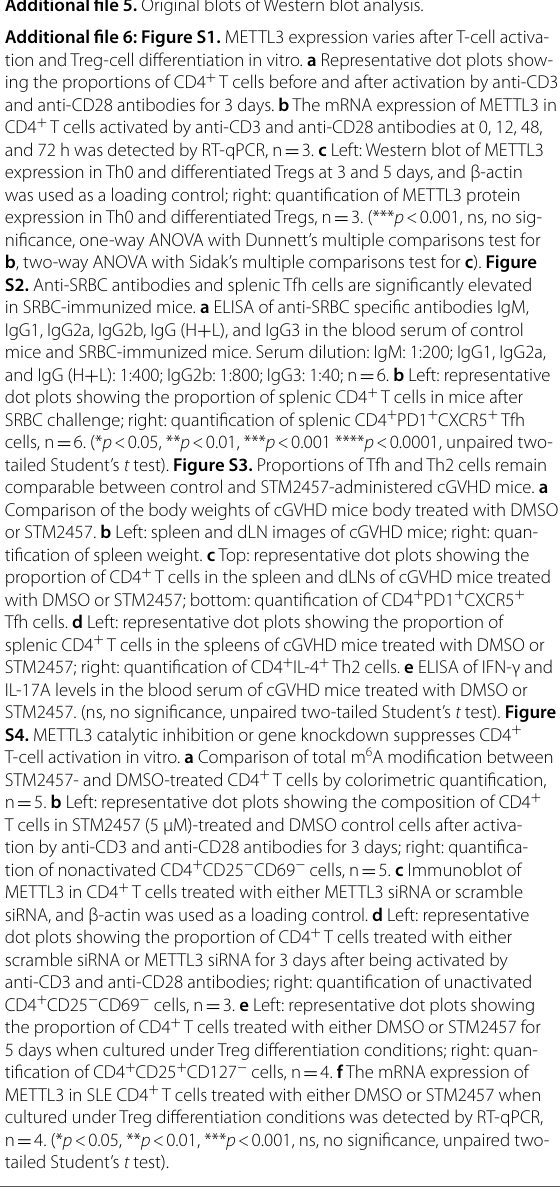
Additional file 5. Original blots of Western blot